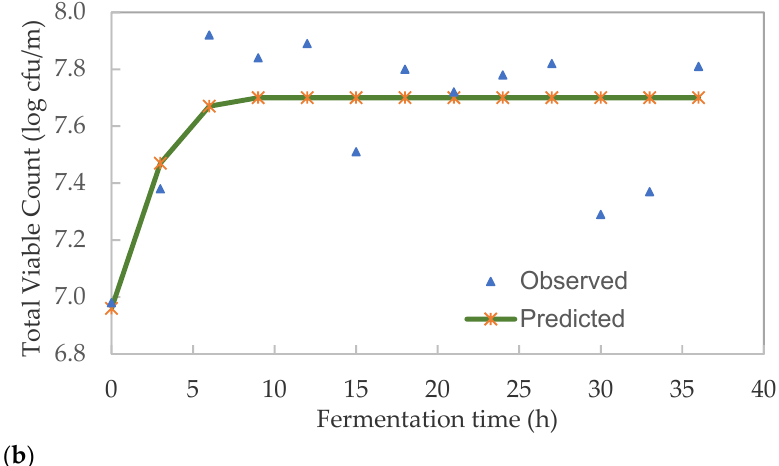
Figure 4. Bacterial growth curve for the fermentation of pearl millet slurry ( a ) LAB—lactic acid bacteria; ( b ) TVC—total viable count.